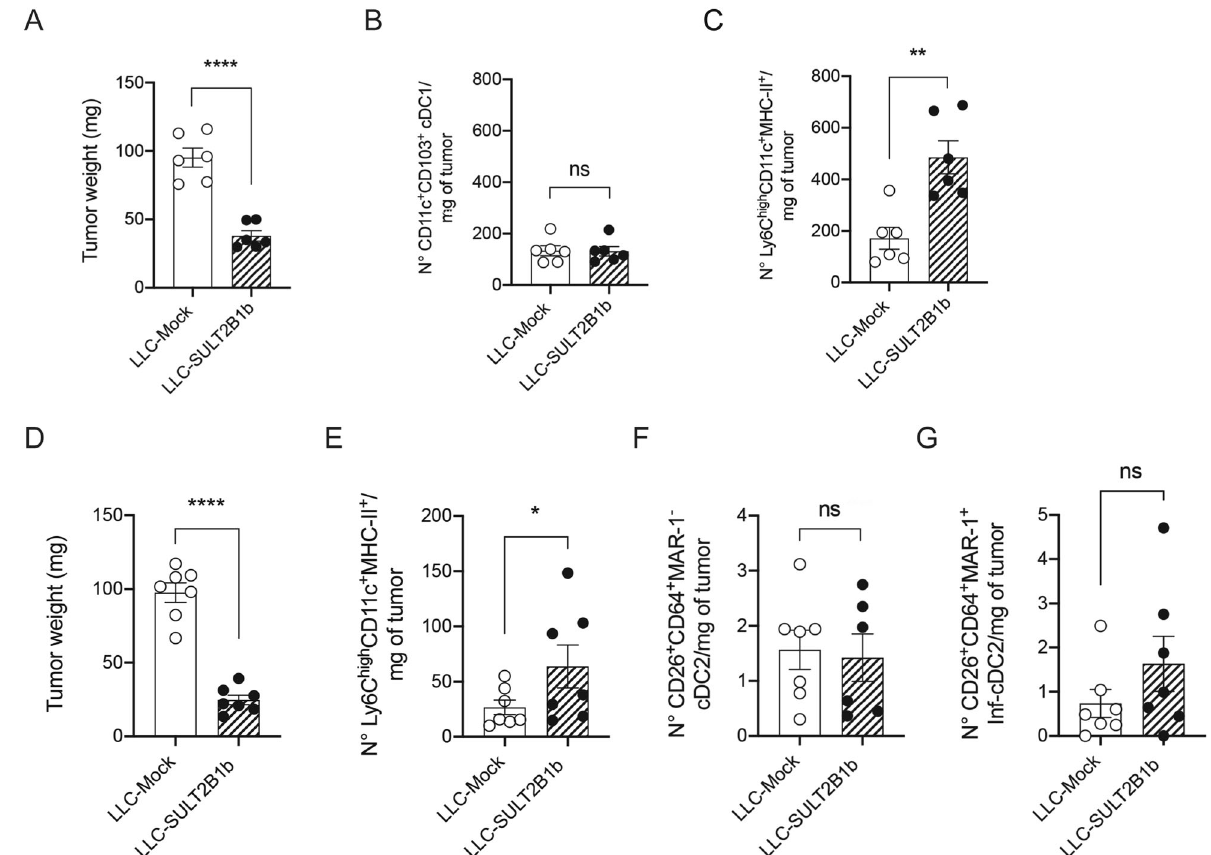
Fig. 2 Analysis of the DC subsets in fi ltrating LLC tumor microenvironment under SULT2B1b perturbation. A Mice challenged with LLC- Mock and LLC-SULT2B1b tumors were sacri fi ced 12 days after tumor challenge and evaluated for tumor weight. Mean and s.d. of 6 mice/ group. **** P < 0.0001 (Student ’ s t-test). The same tumors were analyzed for the number of CD11c + CD103 + cDC1 ( B ) and monocyte-DCs/mg of tumors ( C ). Mean and s.d. of 6 mice/group. ** P < 0.01; ns, not signi fi cant (Student ’ s t-test). D Mice challenged with LLC-Mock and LLC- SULT2B1b tumors were sacri fi ced 10 days after tumor challenge and evaluated for tumor weight. Mean and s.d. of 7 mice/group. **** P < 0.0001 (Student ’ s t-test). E - G Numbers of monocyte-DCs ( E ) CD26 + CD64 + MAR-1 - cDC2 ( F ) and CD26 + CD64 + MAR - 1 + Inf-cDC2/mg of tumors ( G ) . Mean and s.d. of 6-7 mice/group. * P < 0.05 (Student ’ s